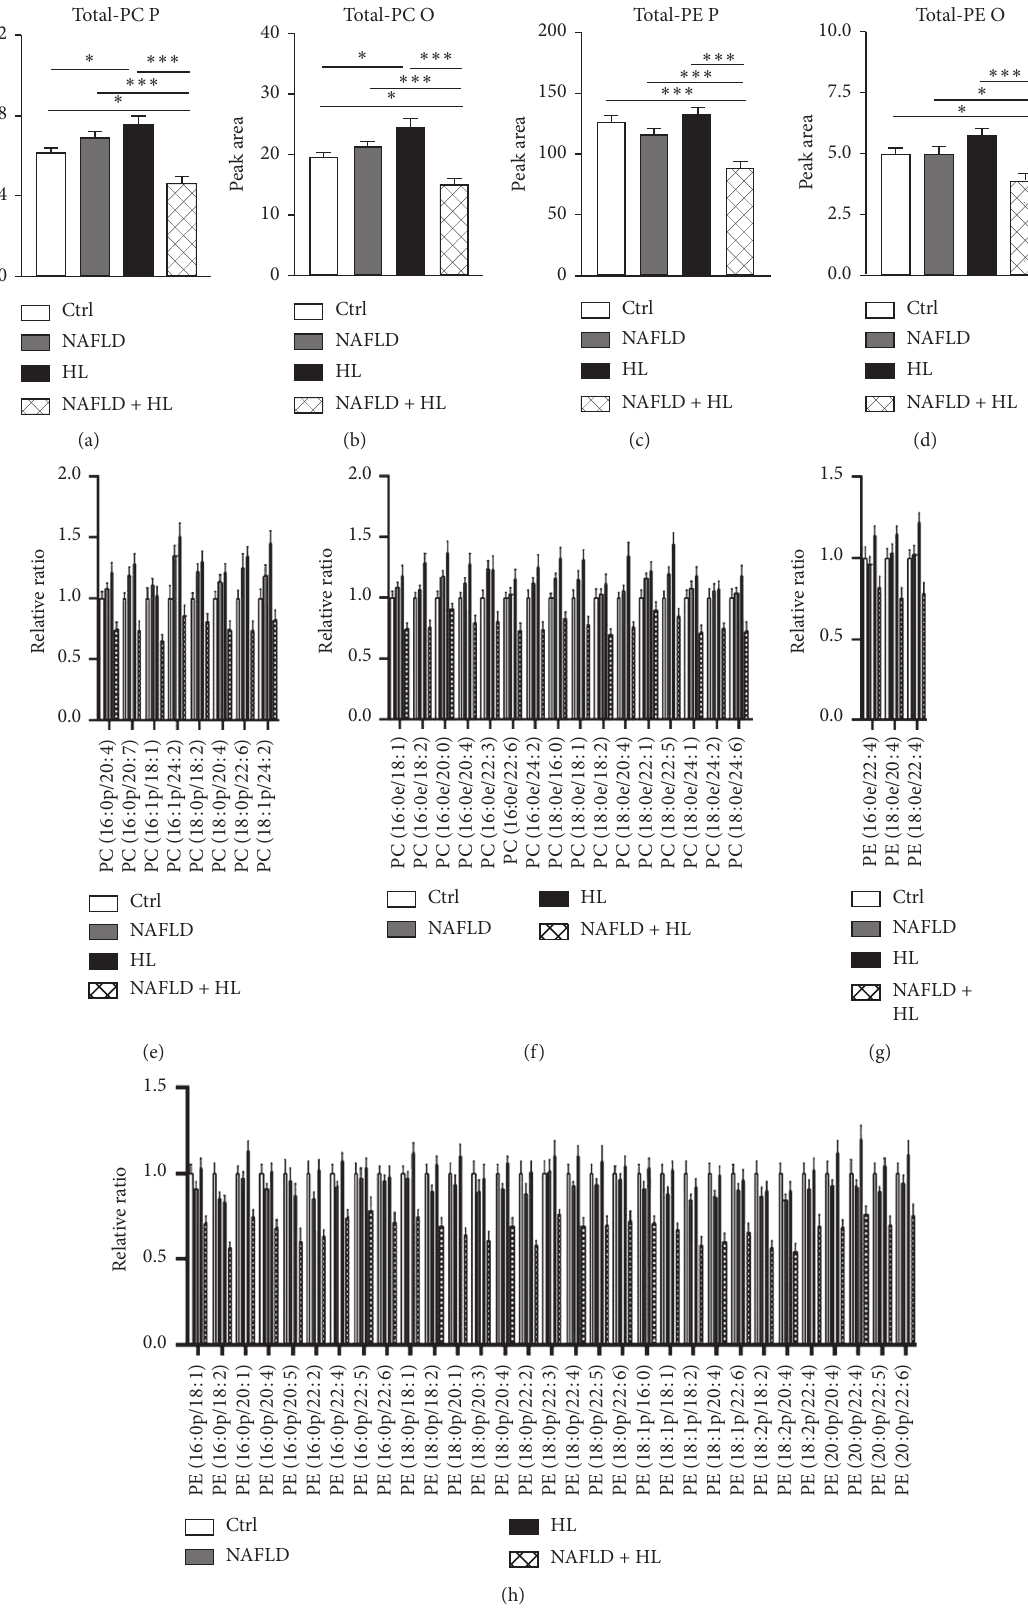
Figure 4: Comparison of the contents of total PC P (a), PC O (b), PE P (c), and PE O (d), relative ratio of individual PC P (e), PC O (f), PE O (g), and PE P (h) in erythrocyte membrane between four groups. Error bars represent the mean ± SD; ∗ p < 0 . 05, ∗∗ p < 0 . 01, ∗∗∗ p < 0 .